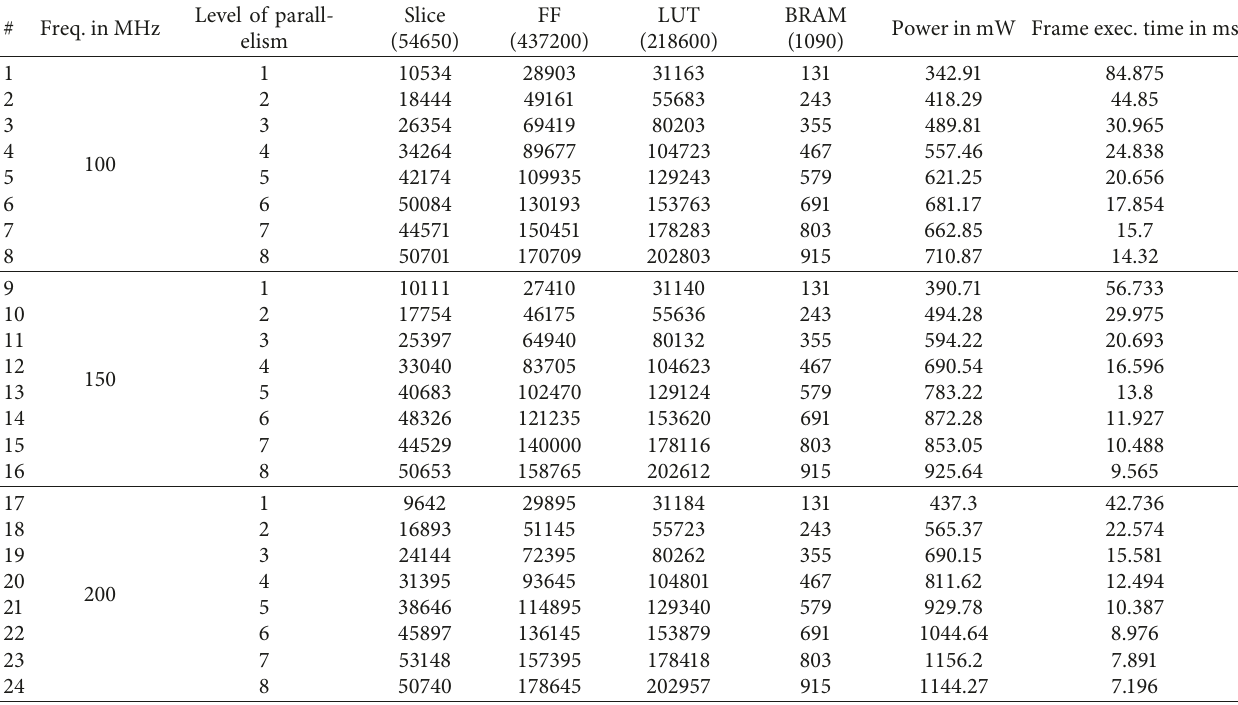
Table 4: Estimations for utilization, power, and frame execution time for pipe4 designs.